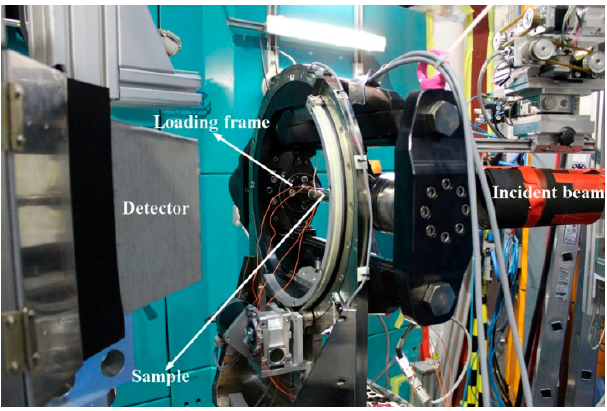
Figure 1. The unique tensile/compression rig installed at STRESS-SPEC for in-situ neutron diffraction